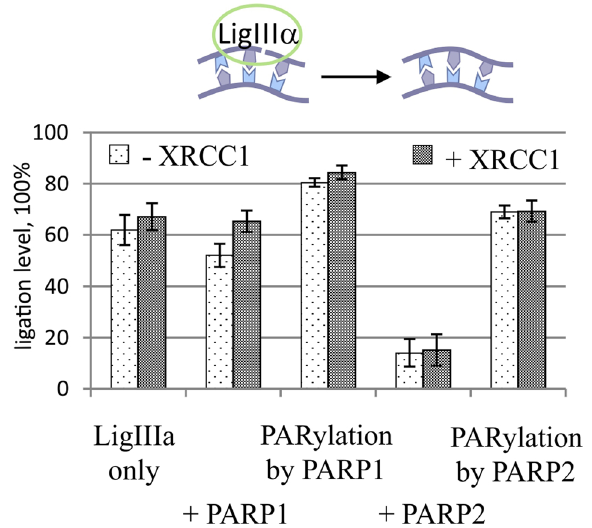
Figure 6. The influence of PARP1 or PARP2 and PARylation on the LigIIIα activity in the absence or presence of XRCC1. The ligation magnitude of the 5 ′ [ 32 P]labelled nicked NCP substrate under the action of LigIIIα was affected by PARP1 or PARP2 and PARylation in the absence or presence of XRCC1. The ligation magnitude was calculated as a percentage of the unreacted primer subtracted from 100%. The data come from experiments involving 20 nM NCP, 500 nM LigIIIα, 100 nM PARP1 or PARP2 and 100 μM NAD + . The data are presented as an average of at least three independent experiments and are shown as the mean values ±